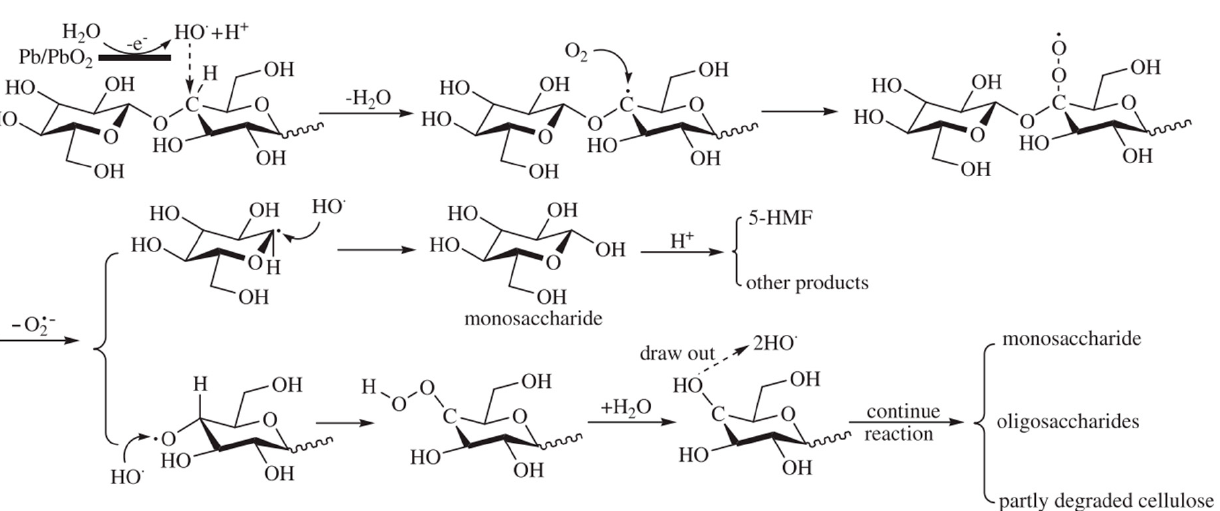
8 of 41 Figure 6. ( a ) CVs (vs. SCE) of 0.5 M sulfuric acid (i) and 0.5 M sulfuric acid with 10 g/L cellulose (ii). ( b ) Decrease in DP over time at 30 mA/cm 2 . ( c ) Decrease in DP over time without applied current. Reprinted with permission from Ref [42].